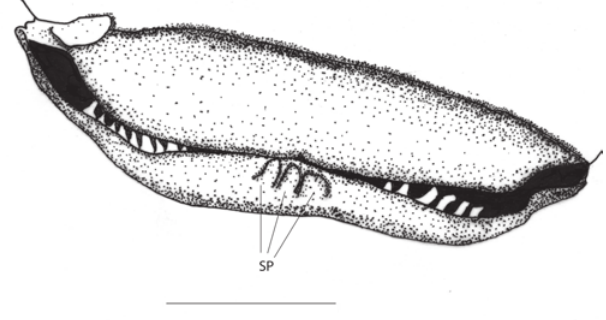
Fig. 26. Upper and lower lip of Phalloceros titthos , MZUSP 43467, showing symphyseal papilla (SP). Scale bar 1